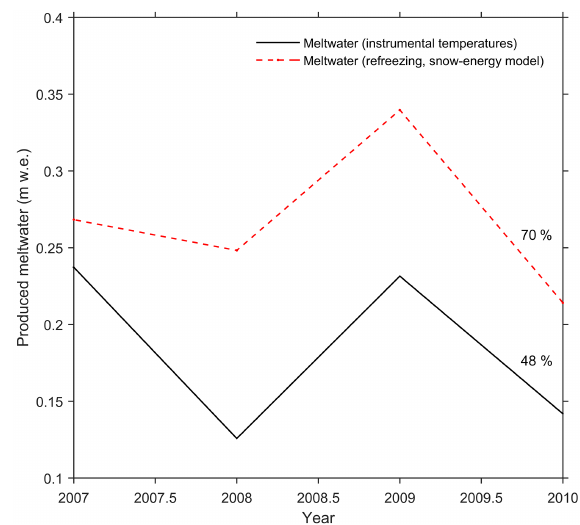
Figure 14. Meltwater calculated at Lomonosovfonna during the pe- riod 2007–2010 using the different approaches: PDD and instru- mental temperatures (black); and the snow–energy model (dashed red). The percentages above each line represent the average melt percentage (MP) during the studied period, estimated by the differ- ent